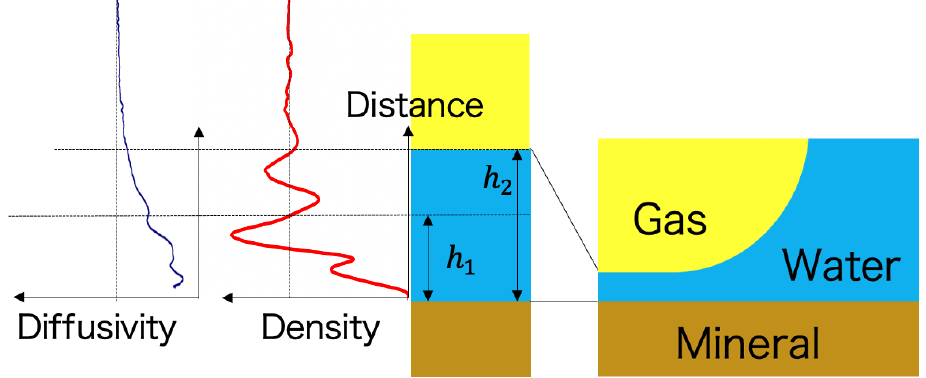
Figure 14. Schematic image of the thin film with two different thicknesses (thinner: h 1 ; thicker: h 2 ) in the gas/water/mineral system.